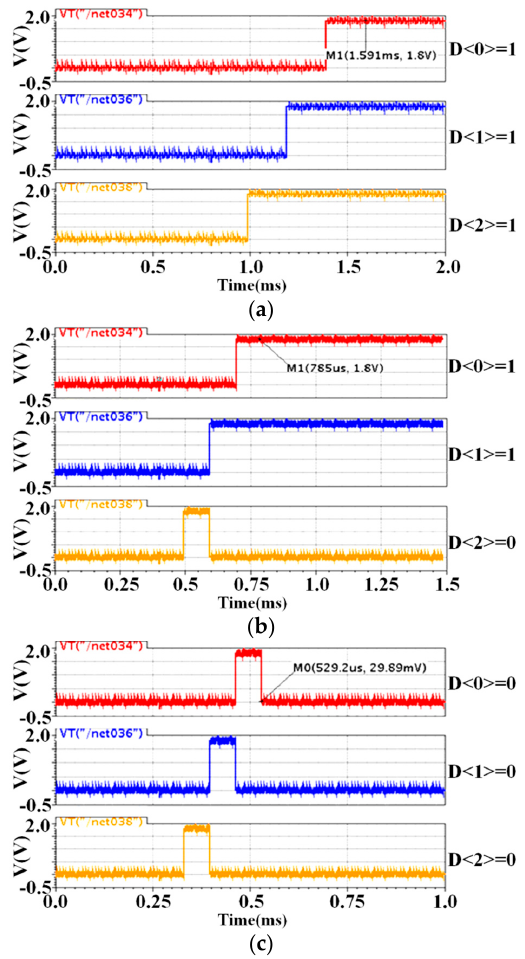
Figure 12. The 3-bit digital code observed in the ATL simulation with an input clock of ( a ) 24.8 kHz, ( b ) 42.8 kHz and ( c ) 60.0